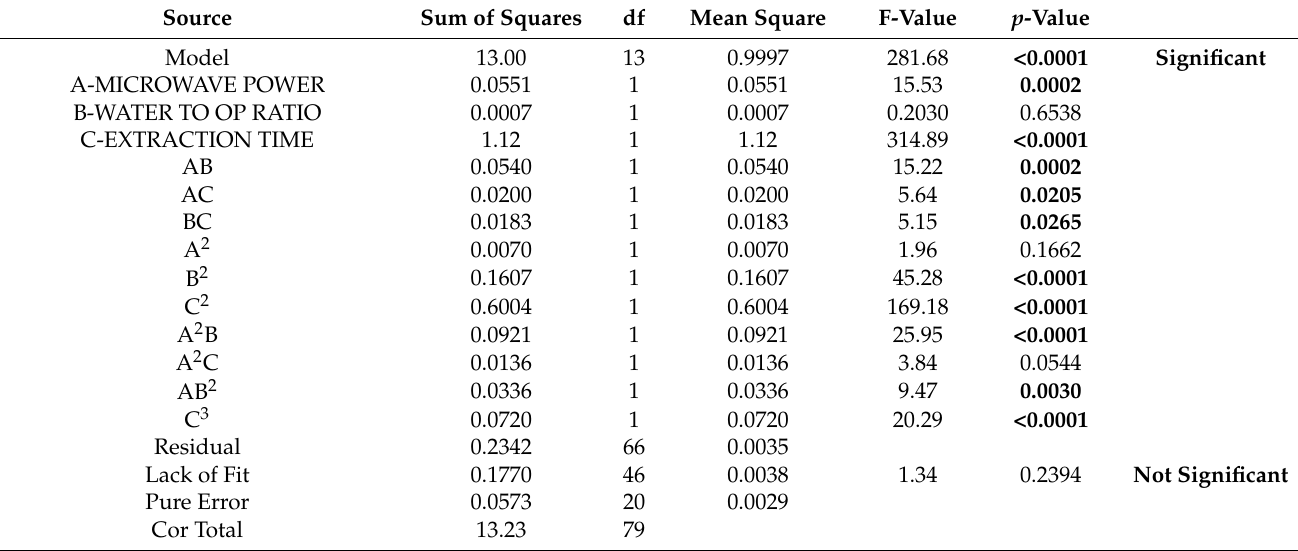
Table 5. Analysis of variance (ANOVA) for the reduced cubic RSM model of OP total polyphenols